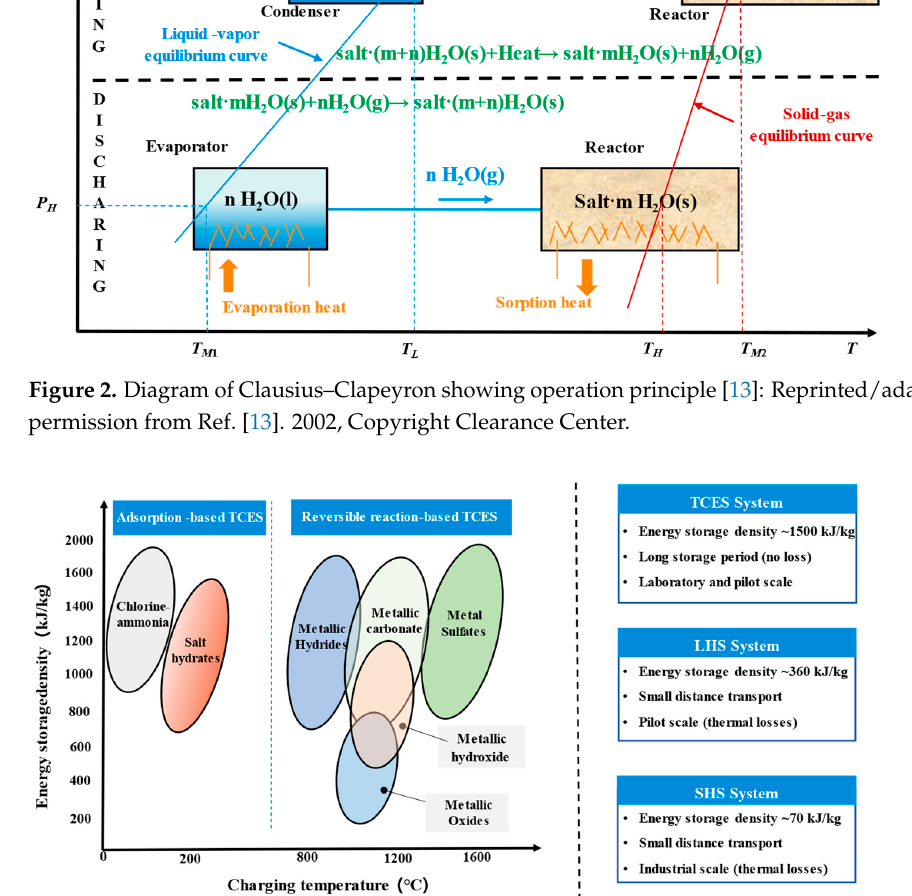
Figure 3. TCES technology ( left ) and some characteristics of TES systems ( right ). Energy density data are typical and approximate. Note: The boxes in right represent the main characteristics of thermochemical energy storage (TCES) system, latent heat storage (LHS) system, and sensible heat storage (SHS) system, respectively.